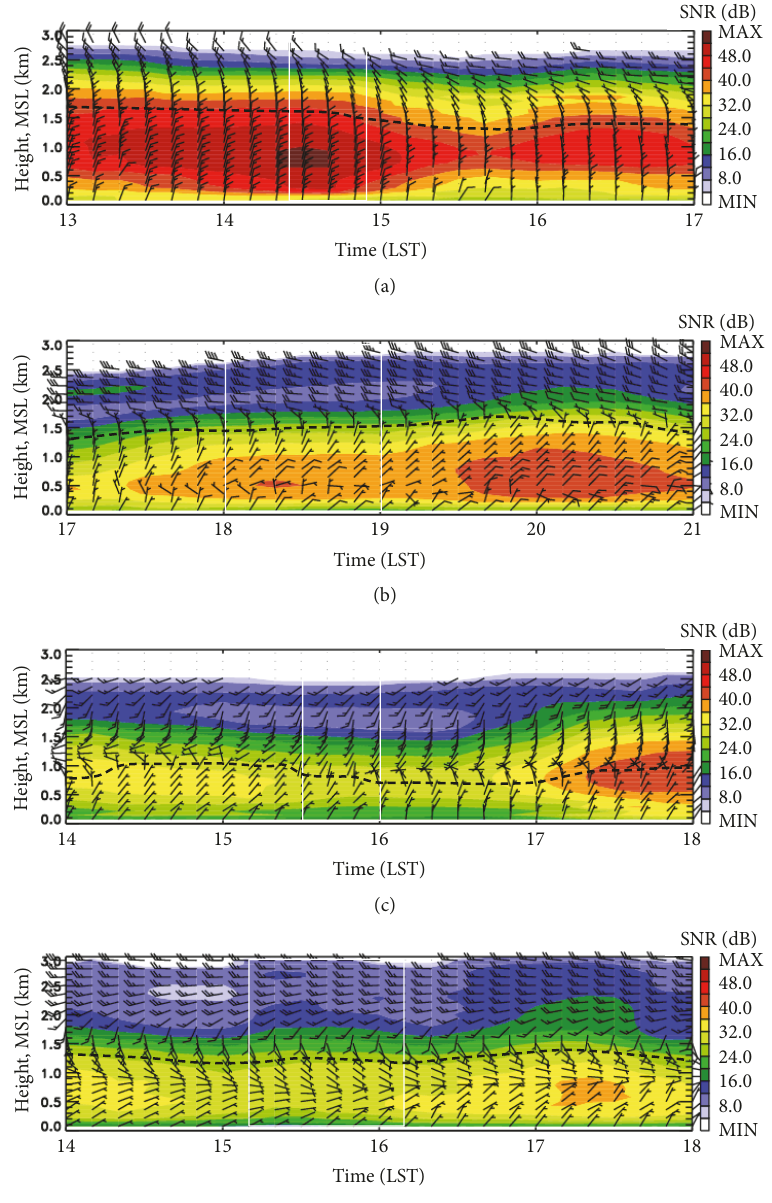
Figure 9: Time series of horizontal wind and the signal-to-noise ratio (SNR) of the wind profiler at GN for (a) EXP1, (b) EXP2, (c) EXP3, and (d) EXP4. The vertical solid lines mark the period of AgI generator operation at CPOS. The dashed line indicates the height of wind change. The details of each experiment are listed in Table